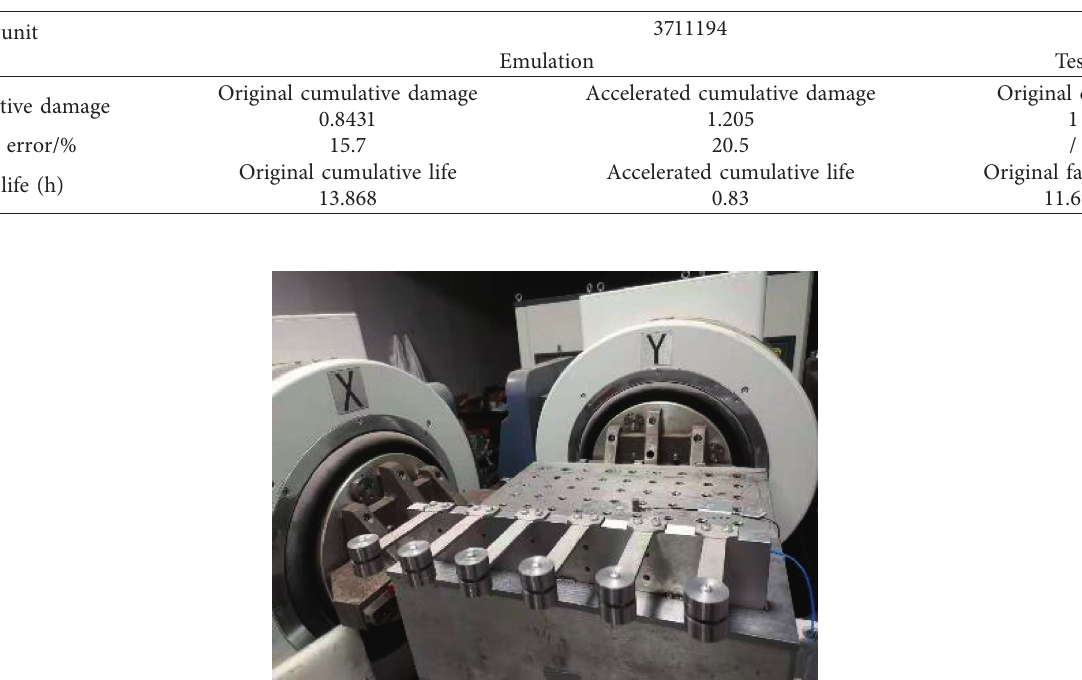
Table 3: Comparison of cumulative damages before and after the acceleration ( b � 5)